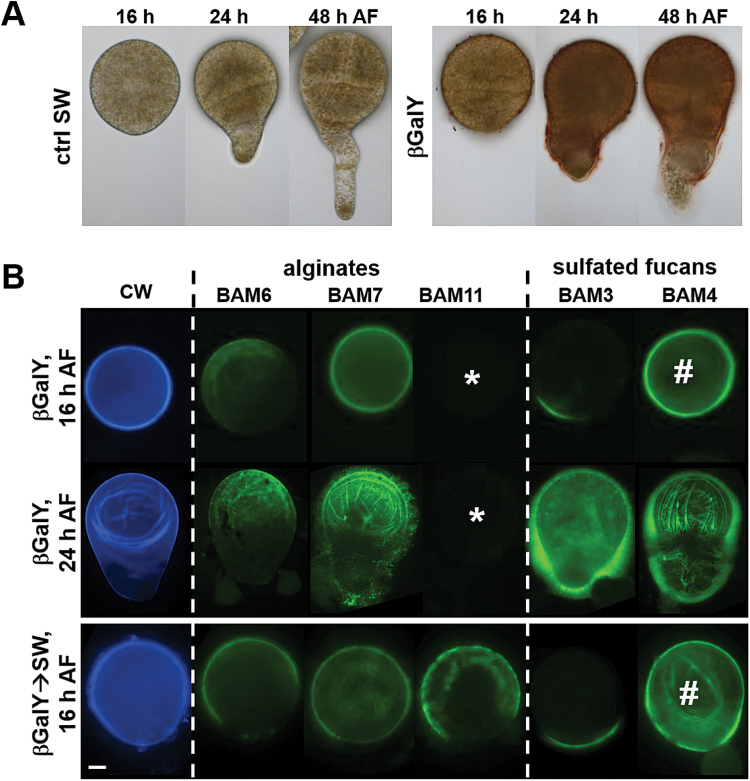
Effect of a βGalY treatment on the deposition of cell wall polysaccharides in developing F. serratus zygotes. (A) Bright field images showing the morphology of the treated zygotes as compared with untreated controls. (B) Indirect immunofluorescence labeling of cell wall polysaccharides. Blue fluorescence shows Calcofluor White stain. Green fluorescence shows the detection of the BAM6, BAM7, and BAM11 alginate epitopes, and the BAM3, BAM4 fucan epitopes. Zygotes were cultivated in the presence of βGalY, either from 1 h AF until the time of observation or for 8 h AF when the reagent was removed and the zygotes allowed to develop for a further 8 h in seawater (βGalY→SW). Scale bar=50 µm.